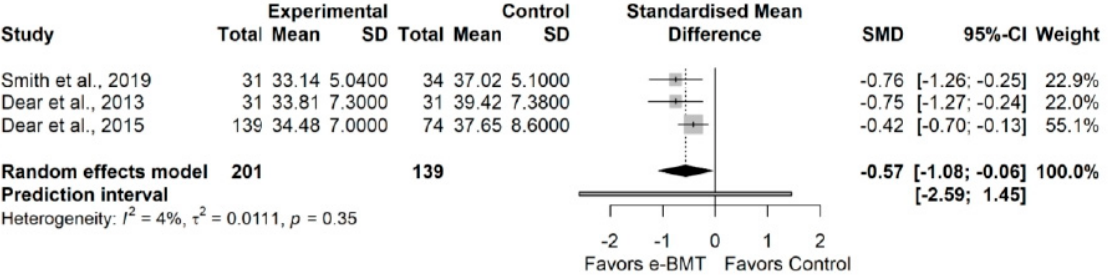
Figure 4. Sensitivity analysis of the kinesiophobia variable for online behavioral techniques against usual care or waiting list. The forest plot summarizes the results of included studies (sample size, mean, standard deviation (SD), standardized mean differences (SMDs), and weight). The small boxes with the squares represent the point estimate of the effect size and sample size. The lines on either side of the box represent a 95% confidence interval (CI).